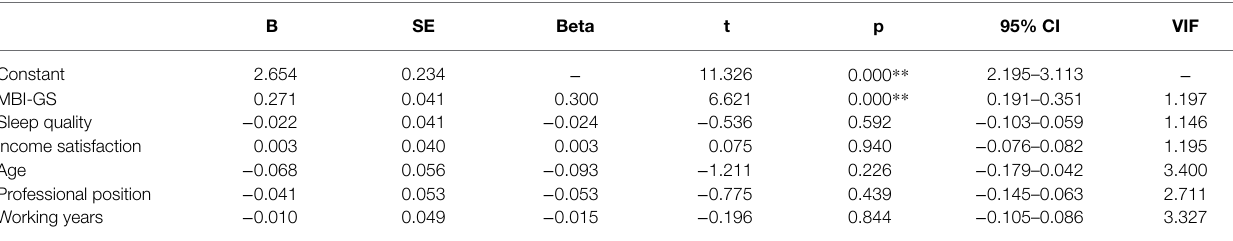
TABLE 7 | Linear regression analysis of the SNSAS ( n =